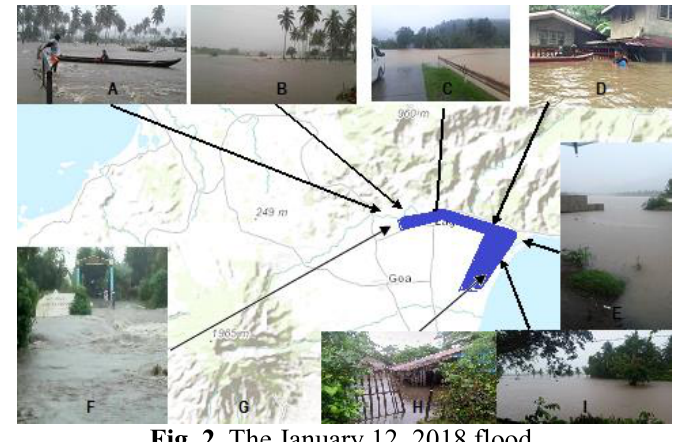
Fig. 2. The January 12, 2018